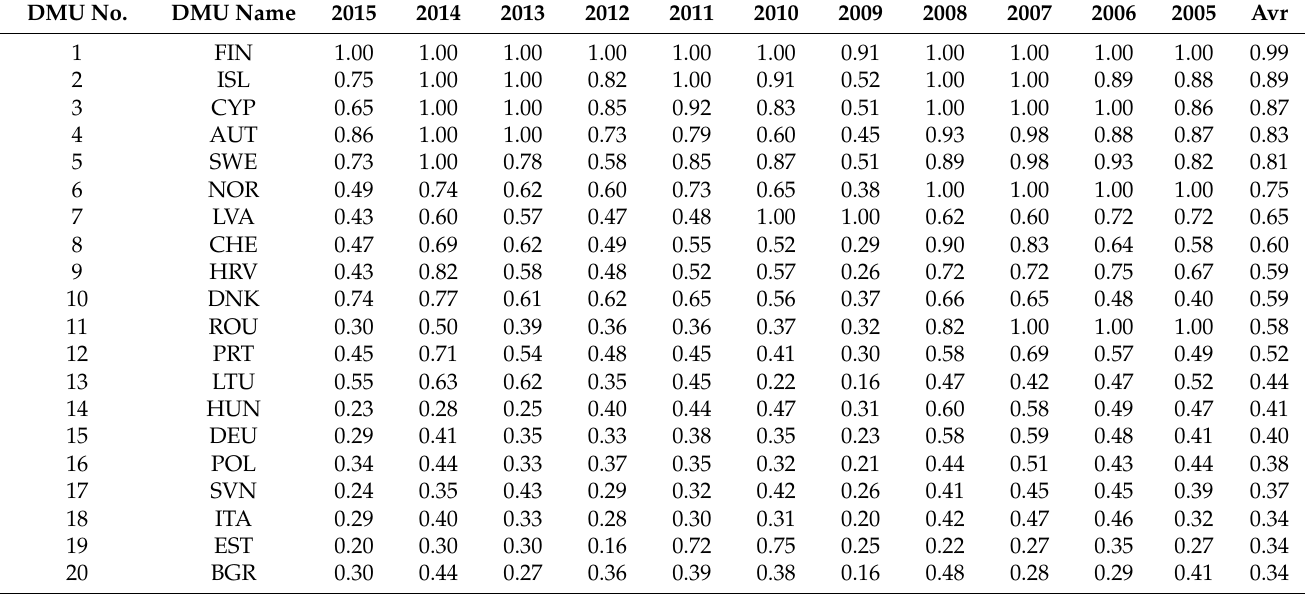
Table 5. Input-Oriented CRS Efficiency of Environmental Protection Expenditure in 2005–2015. Source: Authors’ calculations in